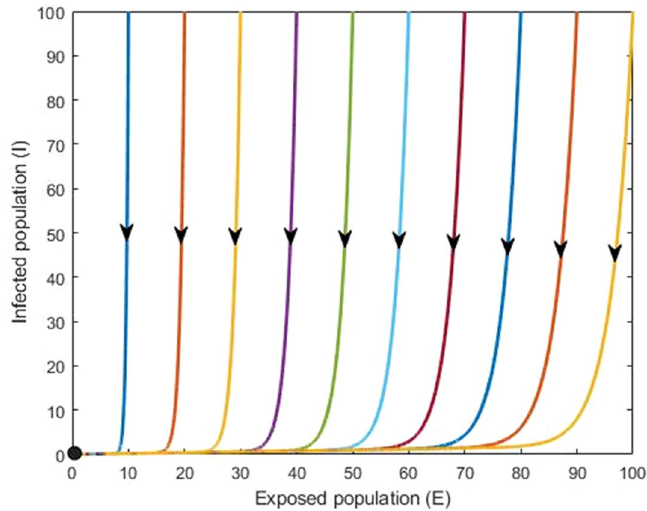
Figure 7. Infection-free equilibrium: R 0 < 1 . In this case measles disease dies out (black dot). All parameter values assume their baseline values given in Table 1.